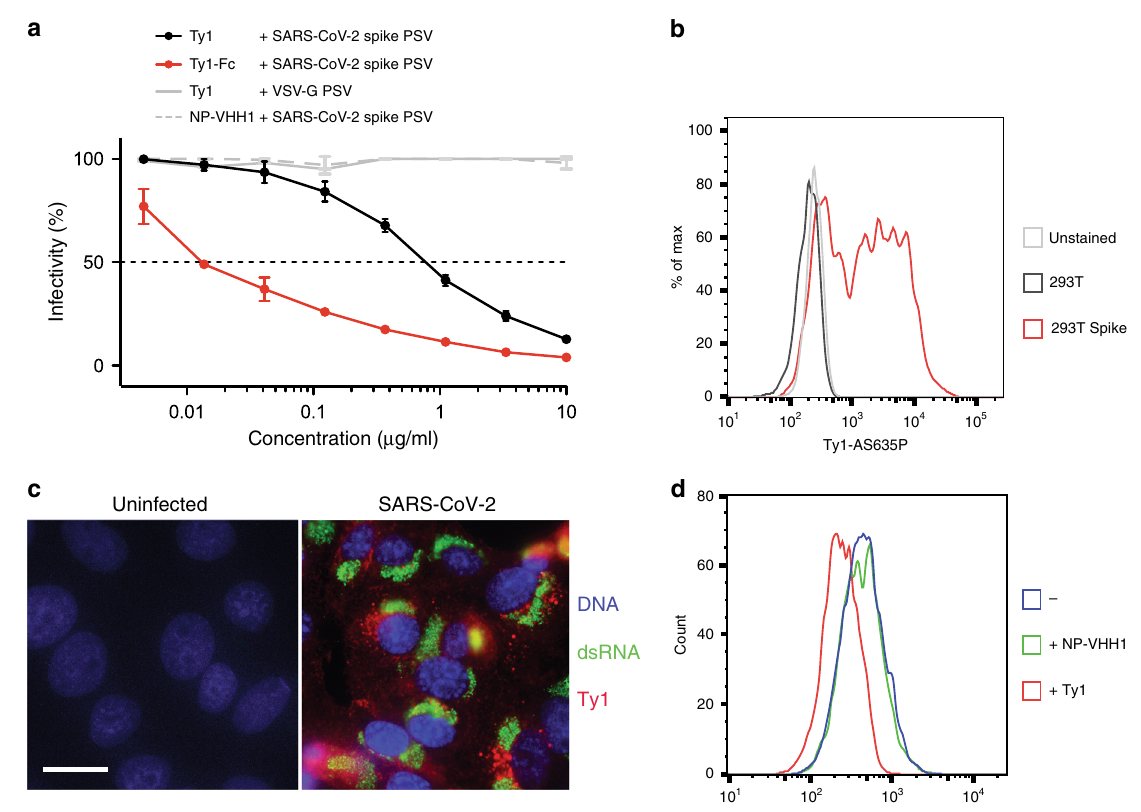
Fig. 2 Ty1 neutralizes SARS-CoV-2 by binding to SARS-CoV-2 spike glycoprotein. a VSV G or SARS-CoV-2 spike pseudotyped lentivirus (PSV) was incubated with a dilution series of Ty1, Ty1-Fc, or control nanobody (NP-VHH1 11 ). Infectivity relative to cells infected with pseudotyped virus in the absence of nanobody is shown. Neutralization by Ty1 was repeated in duplicate across six assays, neutralization by Ty1-Fc was repeated in duplicate across two assays, and the error bars represent the standard deviation. b Cells were transfected with a plasmid harboring the SARS-CoV-2 spike for 24 h. Cells were fi xed, permeabilized, and stained with Ty1-AS635P (black and red) or left unstained (gray). Cells were analyzed by fl ow cytometry. Cell counts are presented as % of max (representative histogram). c Vero E6 cells were infected with SARS-CoV-2 at a MOI of 1 for 24 h. Cells were fi xed, permeabilized, and stained for DNA (blue), dsRNA (green), and with Ty1-AS635P (red). Pictures were taken by fl uorescence microscopy and representative examples are shown. Scale bar, 20 µ m. d ACE2 expressing HEK293T cells were trypsinized, fi xed, and stained with RBD-AS635P alone (blue), or preincubated with NP- VHH1 (green) or Ty1 (red). Cells were analyzed by fl ow